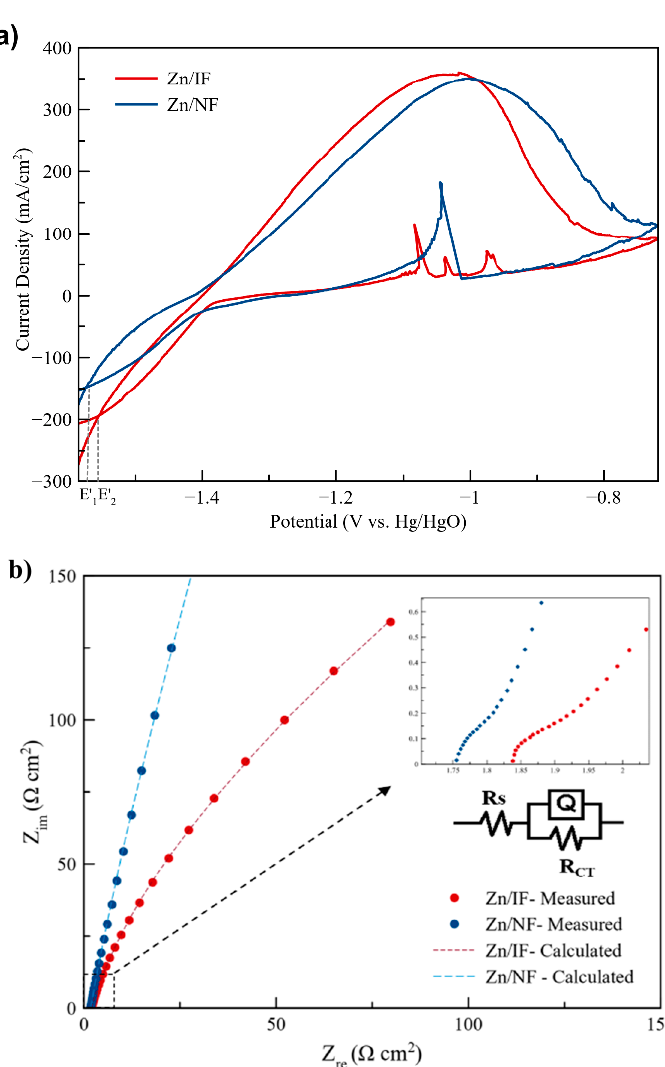
Figure 4. ( a ) CV at a scan rate of 7 mV/s within a potential range of − 1.70 to − 0.7 mV vs. Hg/HgO and ( b ) Nyquist plots with fitted lines and equivalent circuit model at a starting frequency of 100 kHz to 0.1 Hz for Zn/IF and Zn/NF around open-circuit voltage (OCV).